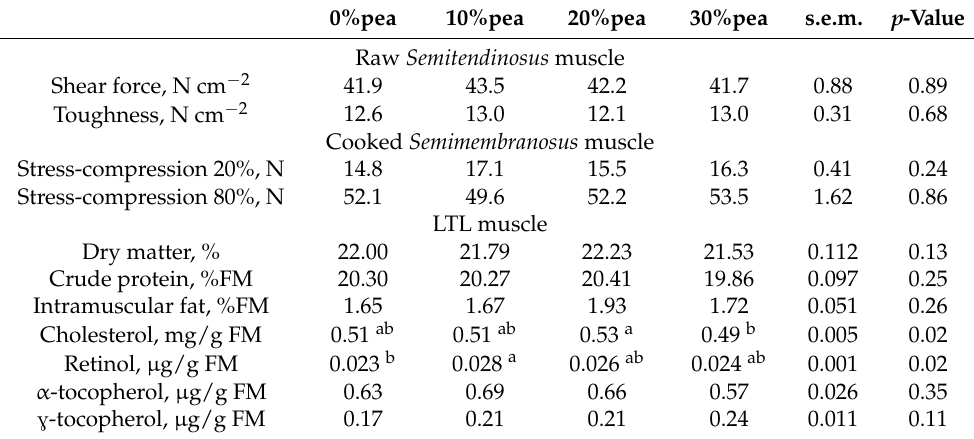
Table 3. Effect of the proportion of pea in the concentrate on texture, chemical composition, choles- terol, retinol and tocopherols in meat.